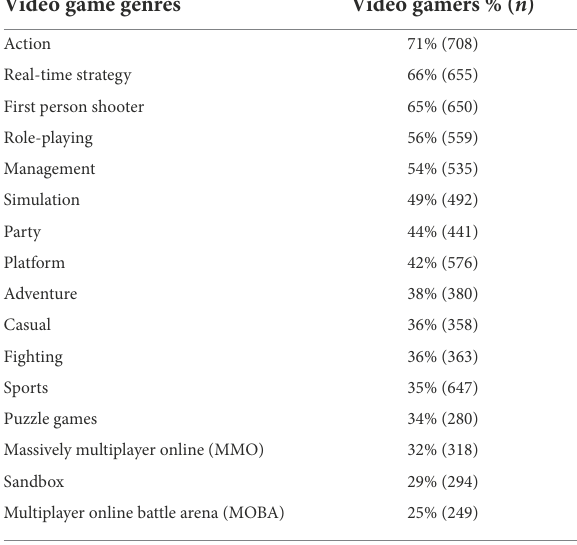
TABLE 1 Prevalence of video gamers at each video game genre in Study 1 ( n = 996).